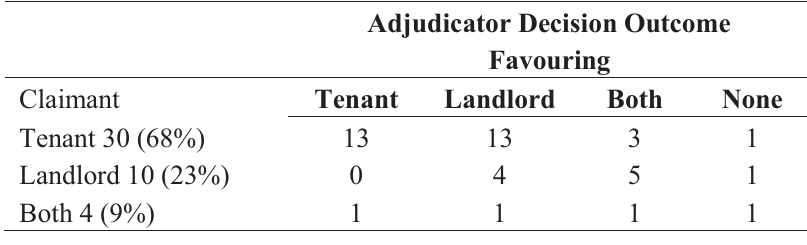
Table 1. Adjudicator Decision Outcomes of Bed Bug Cases.